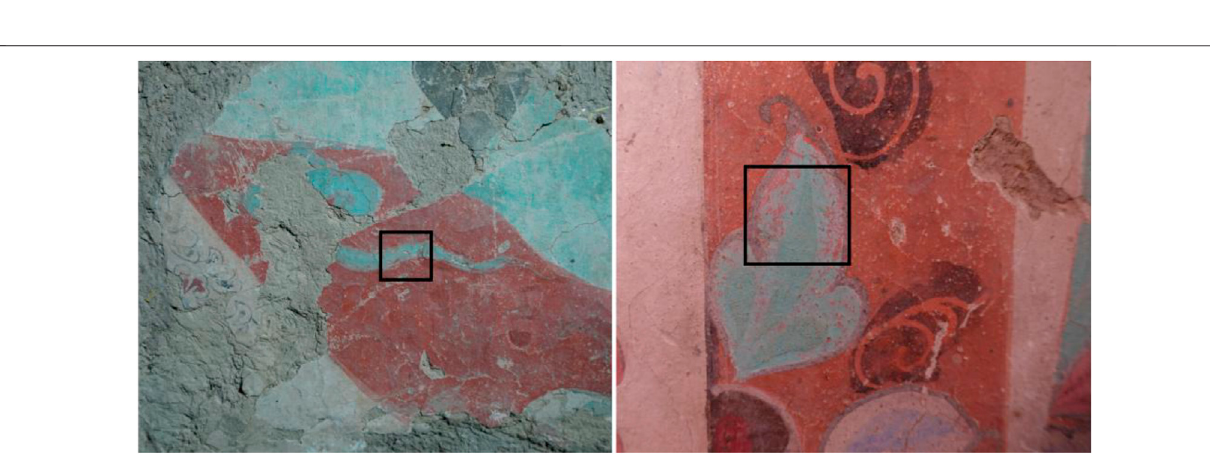
FIGURE 8 | Score plots of PC1 and PC2 for the variance from 250 to 530 nm of green (A) and blue (B) areas mural.